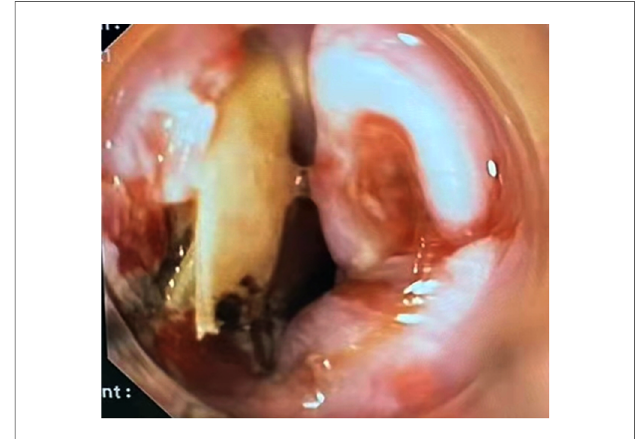
FIGURE 3 The fi shbone was broken by holmium laser endoscopically.